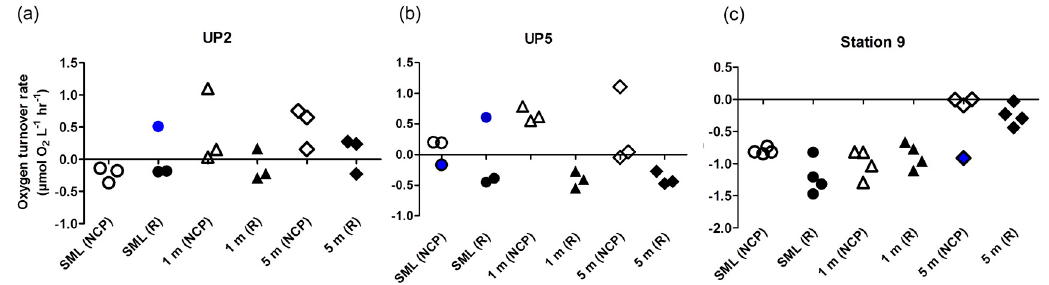
Figure 3. Oxygen turnover rates per hour recorded using the SISI and the light/dark bottle incubation technique for stations in the Baltic Sea ( a , b ) and the Pacific Ocean ( c ). Shown are single replicates and all outliers (blue symbols). NCP = net community production, R = respiration, SML = sea-surface microlayer.